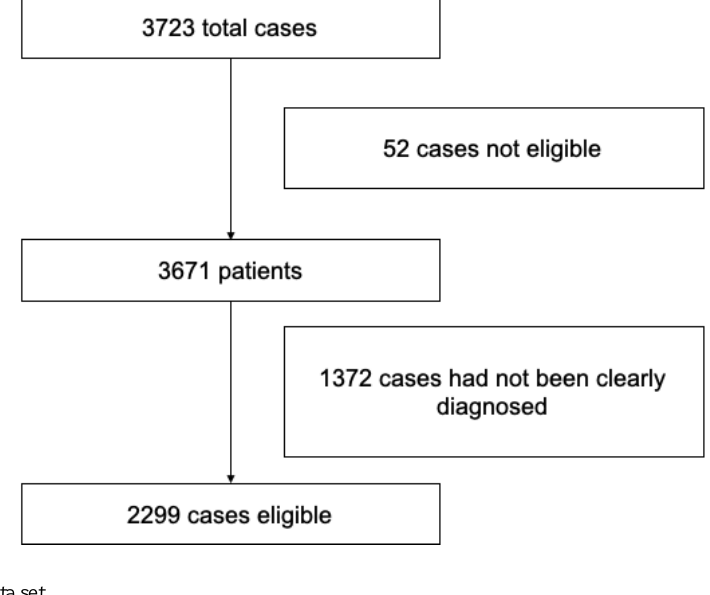
Figure 3. Distribution of the data